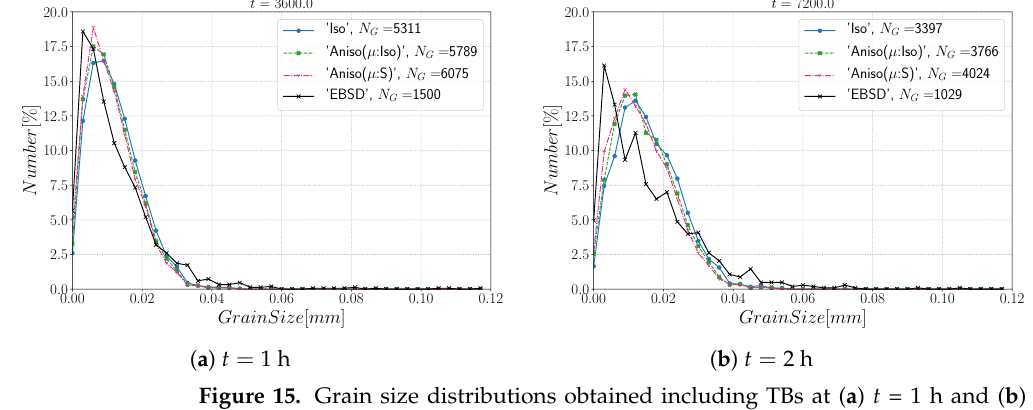
Figure 15. Grain size distributions obtained including TBs at ( a ) t = 1 h and ( b ) t = 2 h for the isotropic (Iso) formulation, anisotropic formulations with isotropic GB mobility (Aniso( µ :Iso)) and heterogeneous GB mobility (Aniso( µ :S)), and the experimental data (EBSD). N G refers to the number.